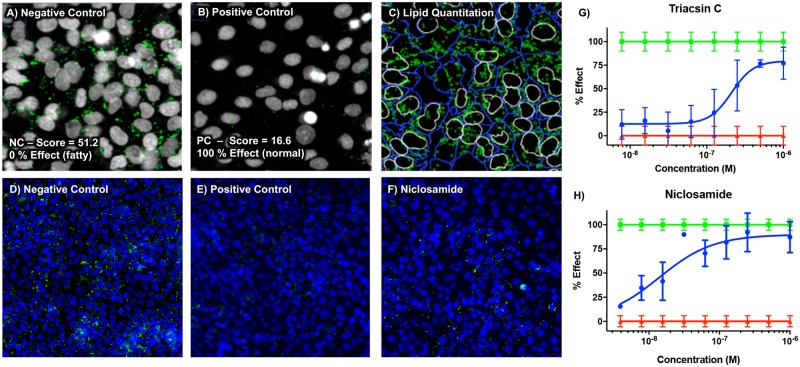
High content lipid quantitation in PH5CH8 liver cells.Negative control cells stimulated for de novo lipid synthesis showing nuclei (gray) and lipids (green) (A) and lipid quantitation of negative control using high-content image analysis resulting in a high lipid score, normalized to 0% effect (C) Positive control—unstimulated cells representing the normal (basal) lipid content with a low lipid score and normalized to 100% effect (B). Representative images from high throughput screening showing negative (D) and positive (E) control wells and stimulated cells treated with 1 μM niclosamide (F). Dose response analysis of test compounds Triacsin C (G) and niclosamide (H) shown in blue. Green and red lines represent the mean and standard error of stimulated and unstimulated cells.